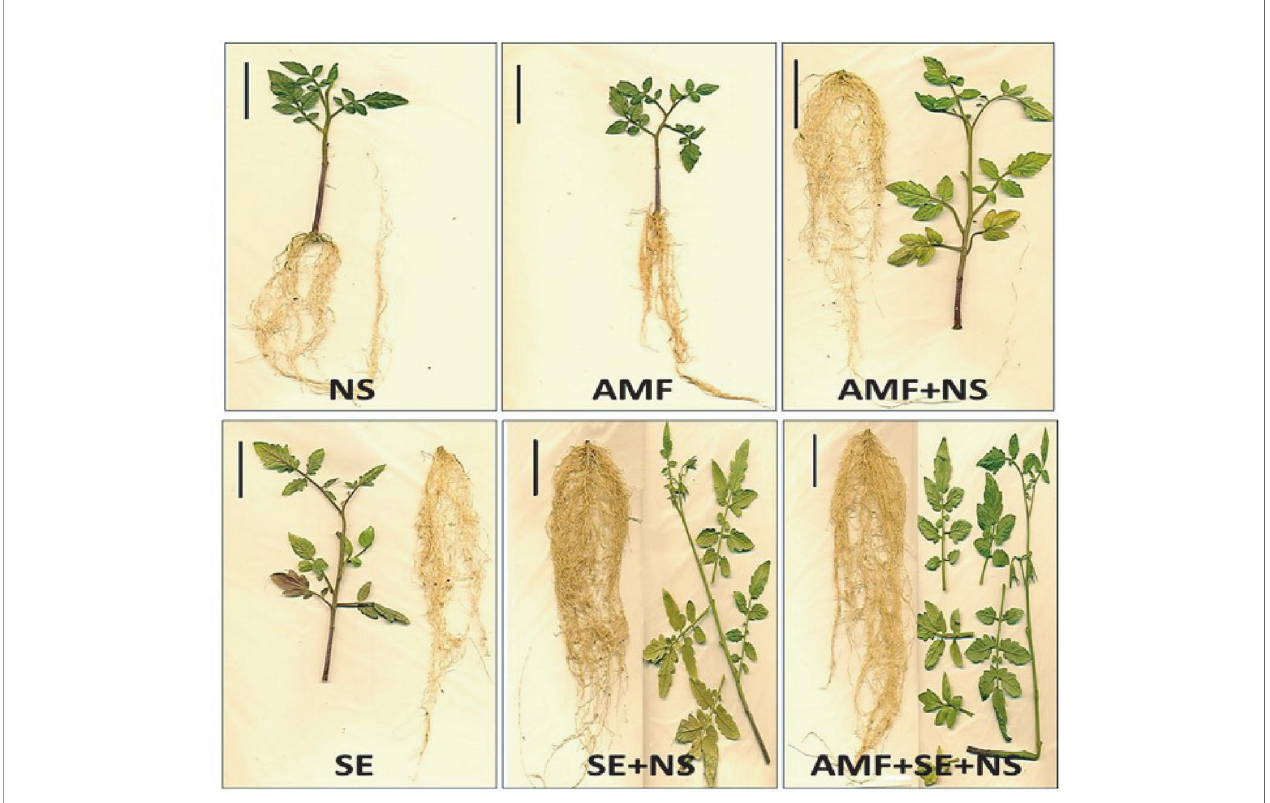
FIGURE 1 | Tomato plant growth after the 96-day experiment. Treatments included plants irrigated with nutritive solution (NS), treated with a microbial-based biostimulant containing Rhizophagus intraradices [arbuscular mycorrhizal fungi (AMF)], treated with an AMF and irrigated with the nutritive solution (AMF + NS), treated with not microbial-based biostimulant from Padina gymnospora extract [seaweed extract (SE)], treated with SE and irrigated with nutritive solution (SE + NS), and a combination of both plant biostimulants plus irrigation with nutritive solution (AMF + SE + NS). Bar,5